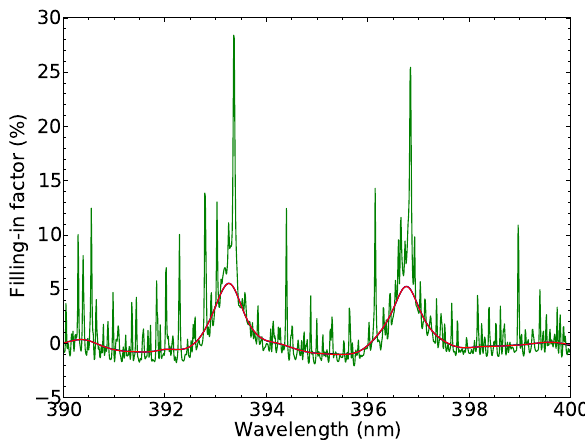
Fig. 2. The filling-in calculated from simulated irradiances at the Earth’s surface using an ET-spectrum with 0.01nm resolu- tion (green line), and ET-spectrum convolved with an instrument (the Bentham spectroradiometer in Garmisch-Partenkirchen with slit function FWHM of 0.5nm, see section 4.1) response function prior to simulation at 0.05nm resolution (red line). Simulations with ET-spectrum with 0.01nm resolution and results convolved with an instrument spectral response function, and the ET-spectrum convolved with the instrument response function prior to simula- tion at 0.01nm resolution (not shown), are indistinguishable from the red line on the present scale. The solar zenith angle is 75 ◦ and the surface albedo is